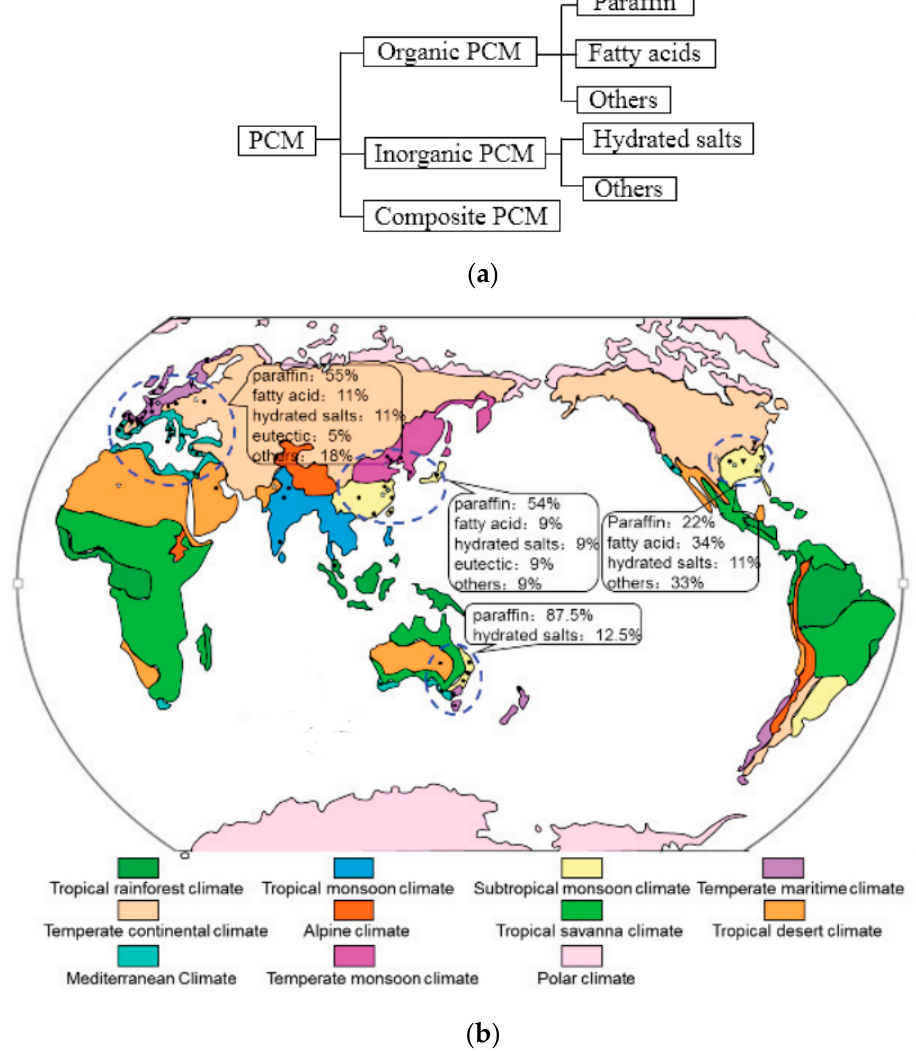
Figure 4 . The classification and the use frequency of different phase changing materials types in various regions worldwide: ( a ) classification; ( b ) use frequency (data from ref. [67]) .